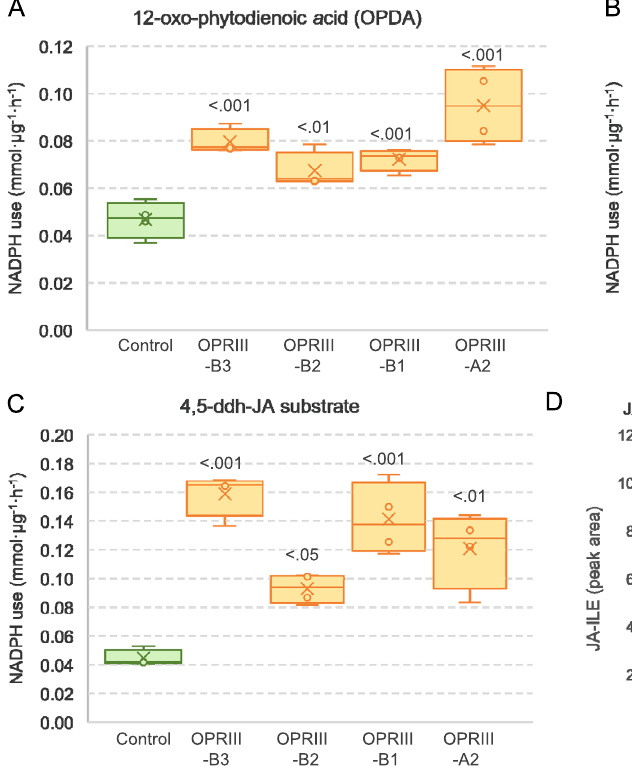
Fig. 4 | OPRIII role in the biosynthesis of JA. A – C Consumption of NADPH (nicotinamide adenine dinucleotide phosphate) by different OPRIII proteins using different substrates. A 12-oxo-phytodienoic acid (OPDA), ( B ) 13-epi-2-oxo-phyto- dienoic acid ( C ) 4,5-ddh-JA. A boiled mixture of recombinant proteins was used as thenegativecontrol. A – C P valuesbasedonDunnetttestsrelativetocontrol( n =4). D JA-Ilecontent in root tips of 1RS( n =5)and 1RW( n =3)at6 DAG. E JA-Ile content